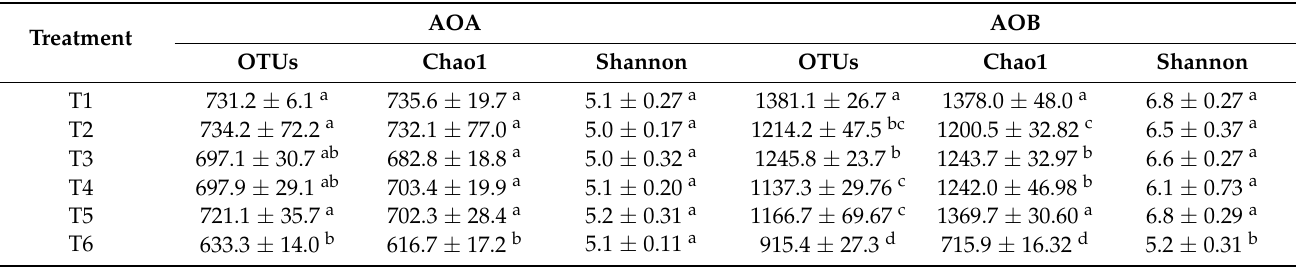
Table 4. Diversity indices of ammonia-oxidizing archaea (AOA) and ammonia-oxidizing bacteria (AOB) at a similarity level of 99% under different substitution ratios.